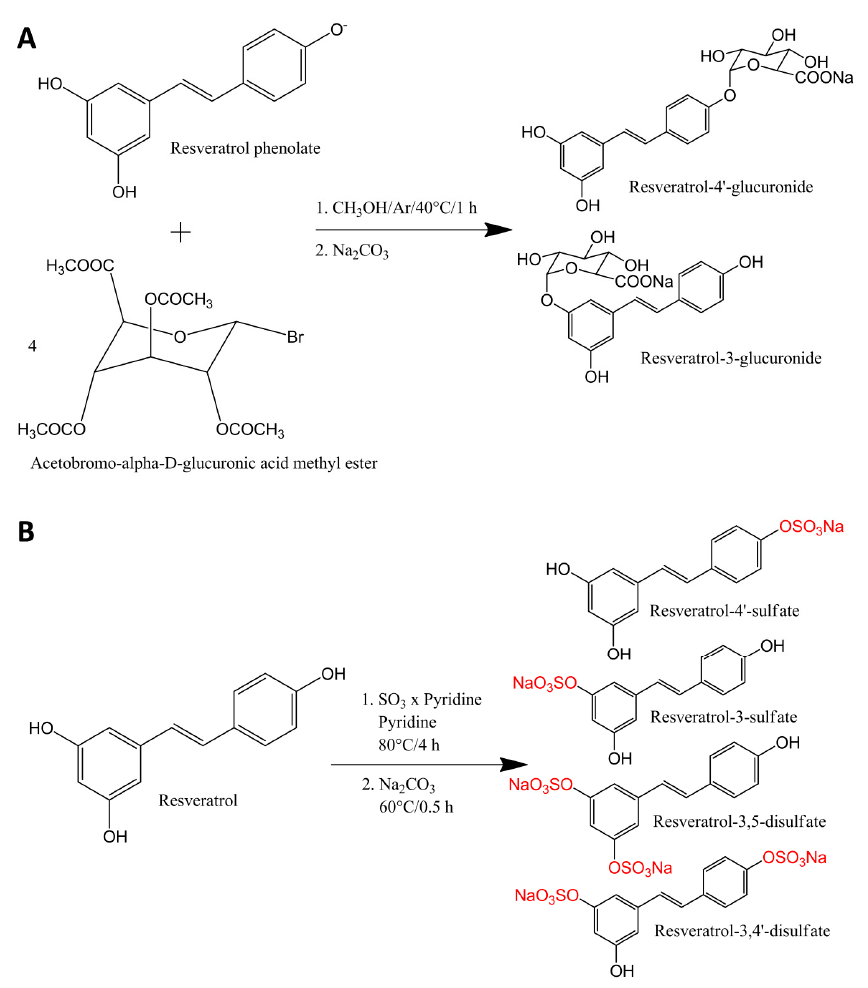
Figure 2. Influence of resveratrol and its metabolites on eNOS enzyme activity. EA.hy926 cells were treated with the indicated concentrations of resveratrol or its metabolites for 24